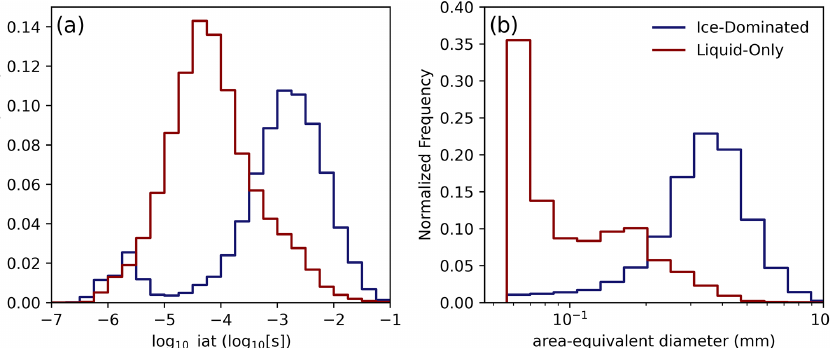
Figure 3. Distributions of the common logarithm of inter-arrival time (a) and particle size (b) for the liquid-only (red) and ice-dominated (blue) data from the TTV